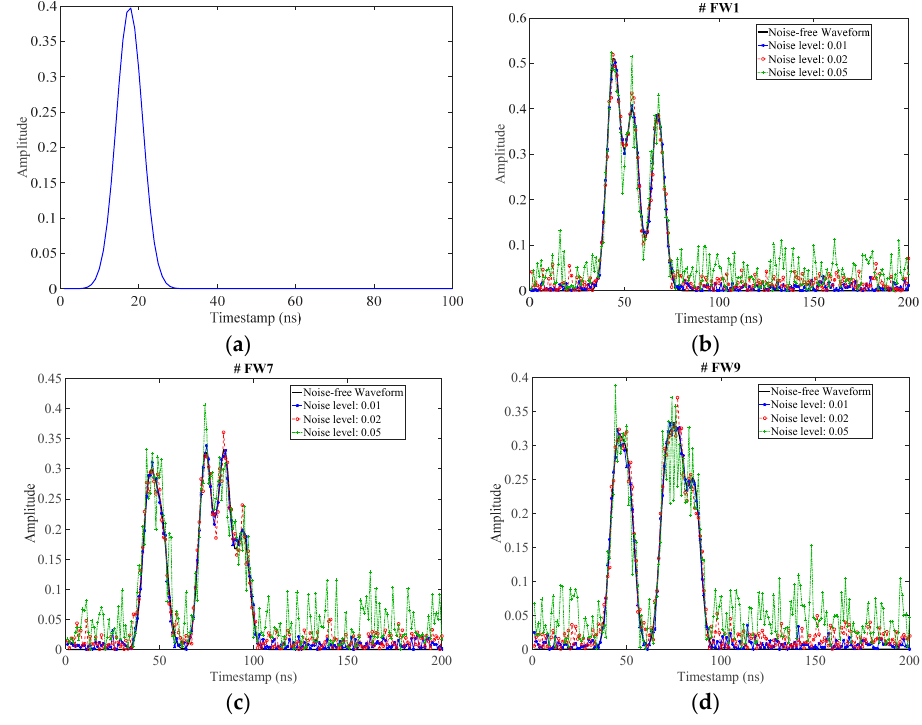
Figure 2. ( a ) The synthetic system waveform; and ( b – d ) selected sample waveforms at different noise levels.